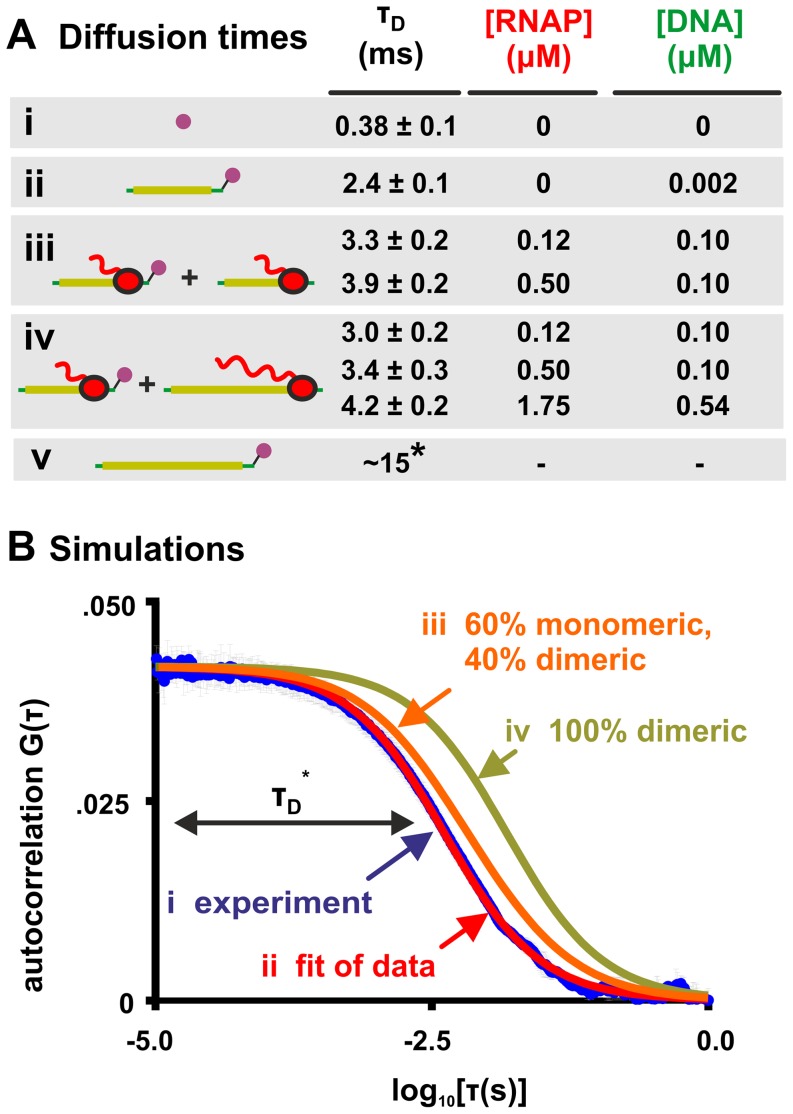
Elongation complexes do not interact in vitro with a Kd<1 µM.
A. The diffusion times (τD) of different fluorescently-labeled molecules (all at 2 nM; fluorophores indicated by purple circles) in buffer LS1, as determined by FCS using a single-species model. (i) Rhodamine 6G alone. (ii) A 70-bp template containing a T7 promoter, a 23-bp C-less cassette, and a C-containing 3′ end labeled with Cy3B. (iii) T7 RNAP ECs. A reaction containing labeled (2 nM) and unlabeled (0.1 µM) 70-bp templates was initiated by the addition of ATP+UTP+GTP, and incubated for 30 s to allow RNAPs to initiate on the templates and halt at the first C residues; then, the average diffusion time of the labeled templates was measured. (iv) As in (iii), except the unlabeled 70-bp template is replaced by an unlabeled 452-bp template encoding a T7 promoter, a C-less cassette, and a C-containing 3′ end (at 0.1–0.54 µM). This replacement does not significantly change the diffusion time of the labeled ECs, suggesting that they do not interact with unlabeled ECs. (v) Estimated diffusion time of the 452-bp template alone (Text S1C). For all τD values, error was calculated using standard deviation (n≥3). B. Expected RNAP clustering. (i) An autocorrelation curve measured in the experiment of Fig. 2Aiv (template and RNAP concentrations were 0.54 µM and 1.75 µM). Error bars represent standard deviation (n = 3). (ii) A fit of (i) using a single species model (Eq. 1); τD = 4.2 ms. (iii) The calculated autocorrelation function one would observe in the experiment (i), if RNAPs interacted with a Kd of 1 µM (calculated using a two-species model, Eq. 2). Sixty percent of labeled ECs diffuse freely with τD = 4 ms, while 40% are in RNAP dimers containing a 452-bp template, and so have a τD of 15 ms. This curve yields a τD of 6.0 ms when fit using a single-species model, and is clearly distinguishable from the measured data of (i). (iv) The autocorrelation function one would expect to observe in the experiment (i), were all labeled ECs to interact with a 452-bp template; all complexes have a τD of 15 ms.